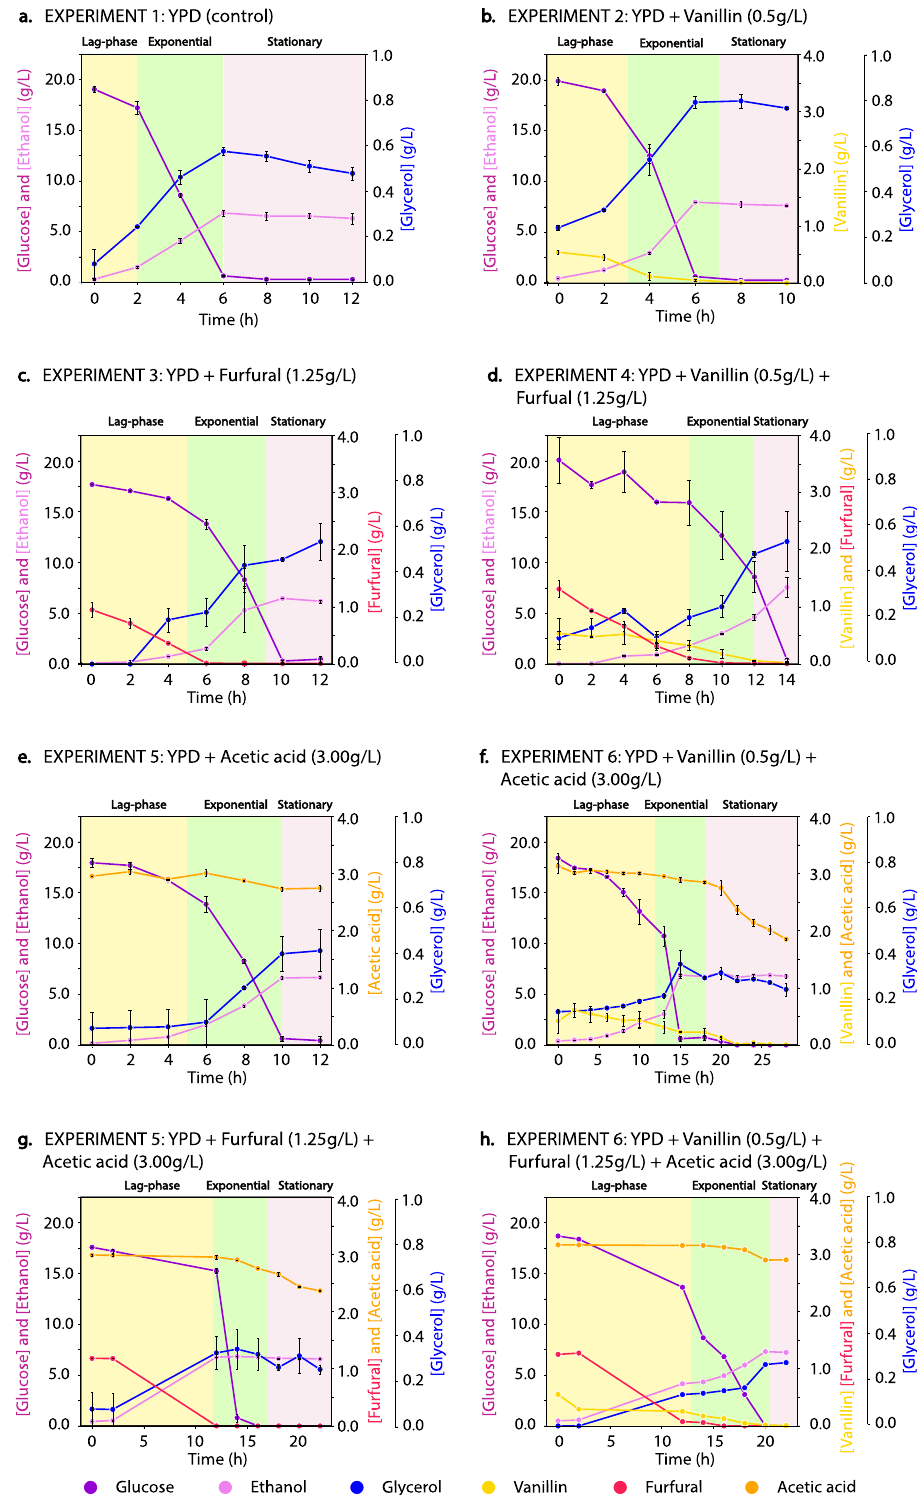
Figure 2. Profile of the extracellular metabolites through experiments 1–8. The plots show substrate (glucose), product (ethanol and glycerol) and inhibitors (vanillin, furfural and acetic acid) concentrations measured during each fermentation. ( a ) YPD control, ( b ) addition of vanillin (0.5 g/L), ( c ) addition of furfural (1.25 g/L), ( d ) addition of vanillin (0.5 g/L) and furfural (1.25 g/L), ( e ) addition of acetic acid (3 g/L), ( f ) addition of vanillin (0.5 g/L) and acetic acid (3 g/L), ( g ) addition of furfural (1.25 g/L) and acetic acid (3 g/L), ( h ) addition of vanillin (0.5 g/L) furfural (1.25 g/L) and acetic acid (3 g/L). For fermentations 1–7, the plotted values are the average of two replicates and the error bars indicate the difference between the two replicates. Note that for fermentation 8, only one replicate was measured. This figure was produced using Python 70